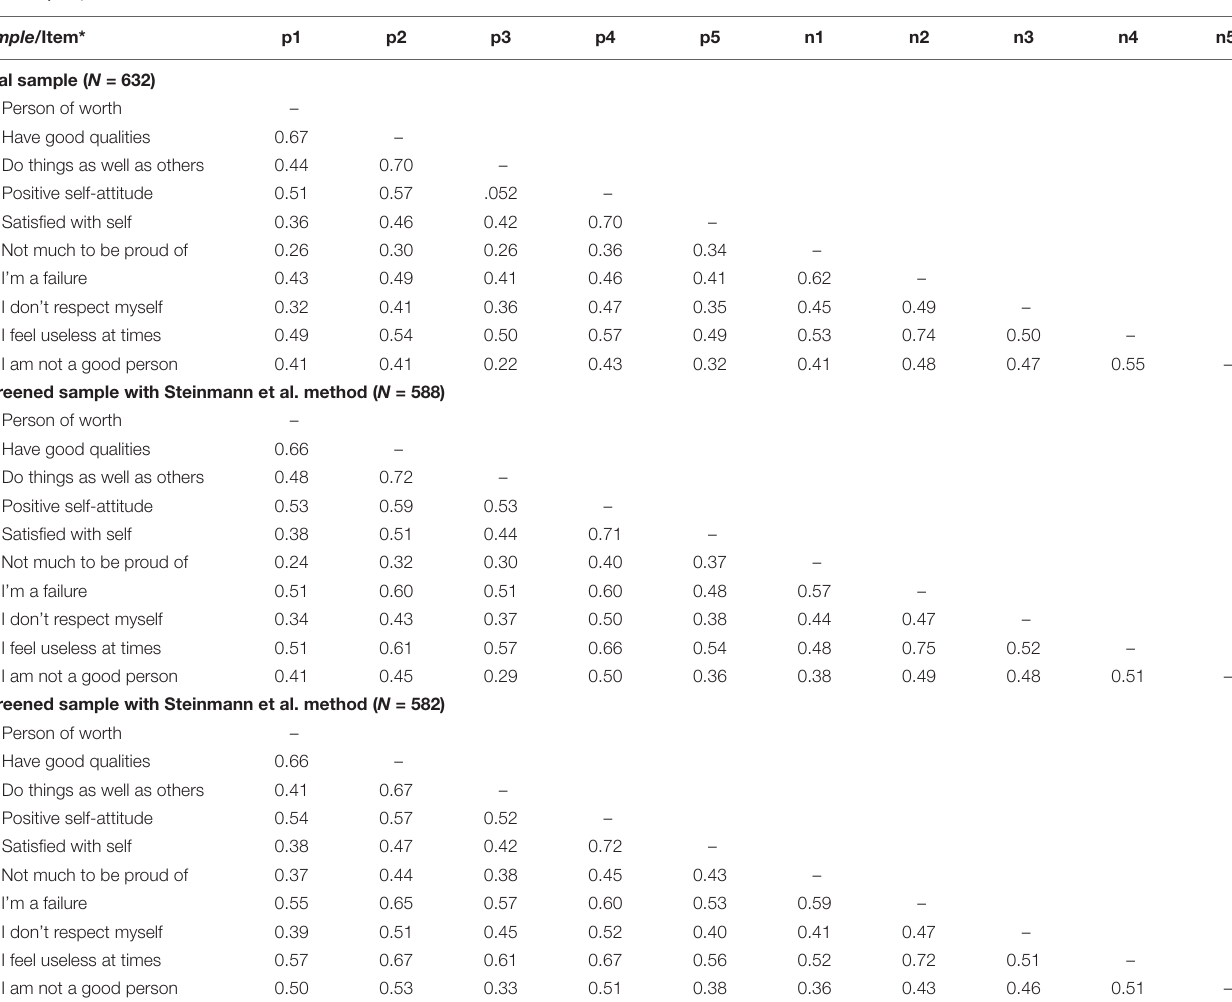
TABLE 1 | Polychoric correlations between the RSES